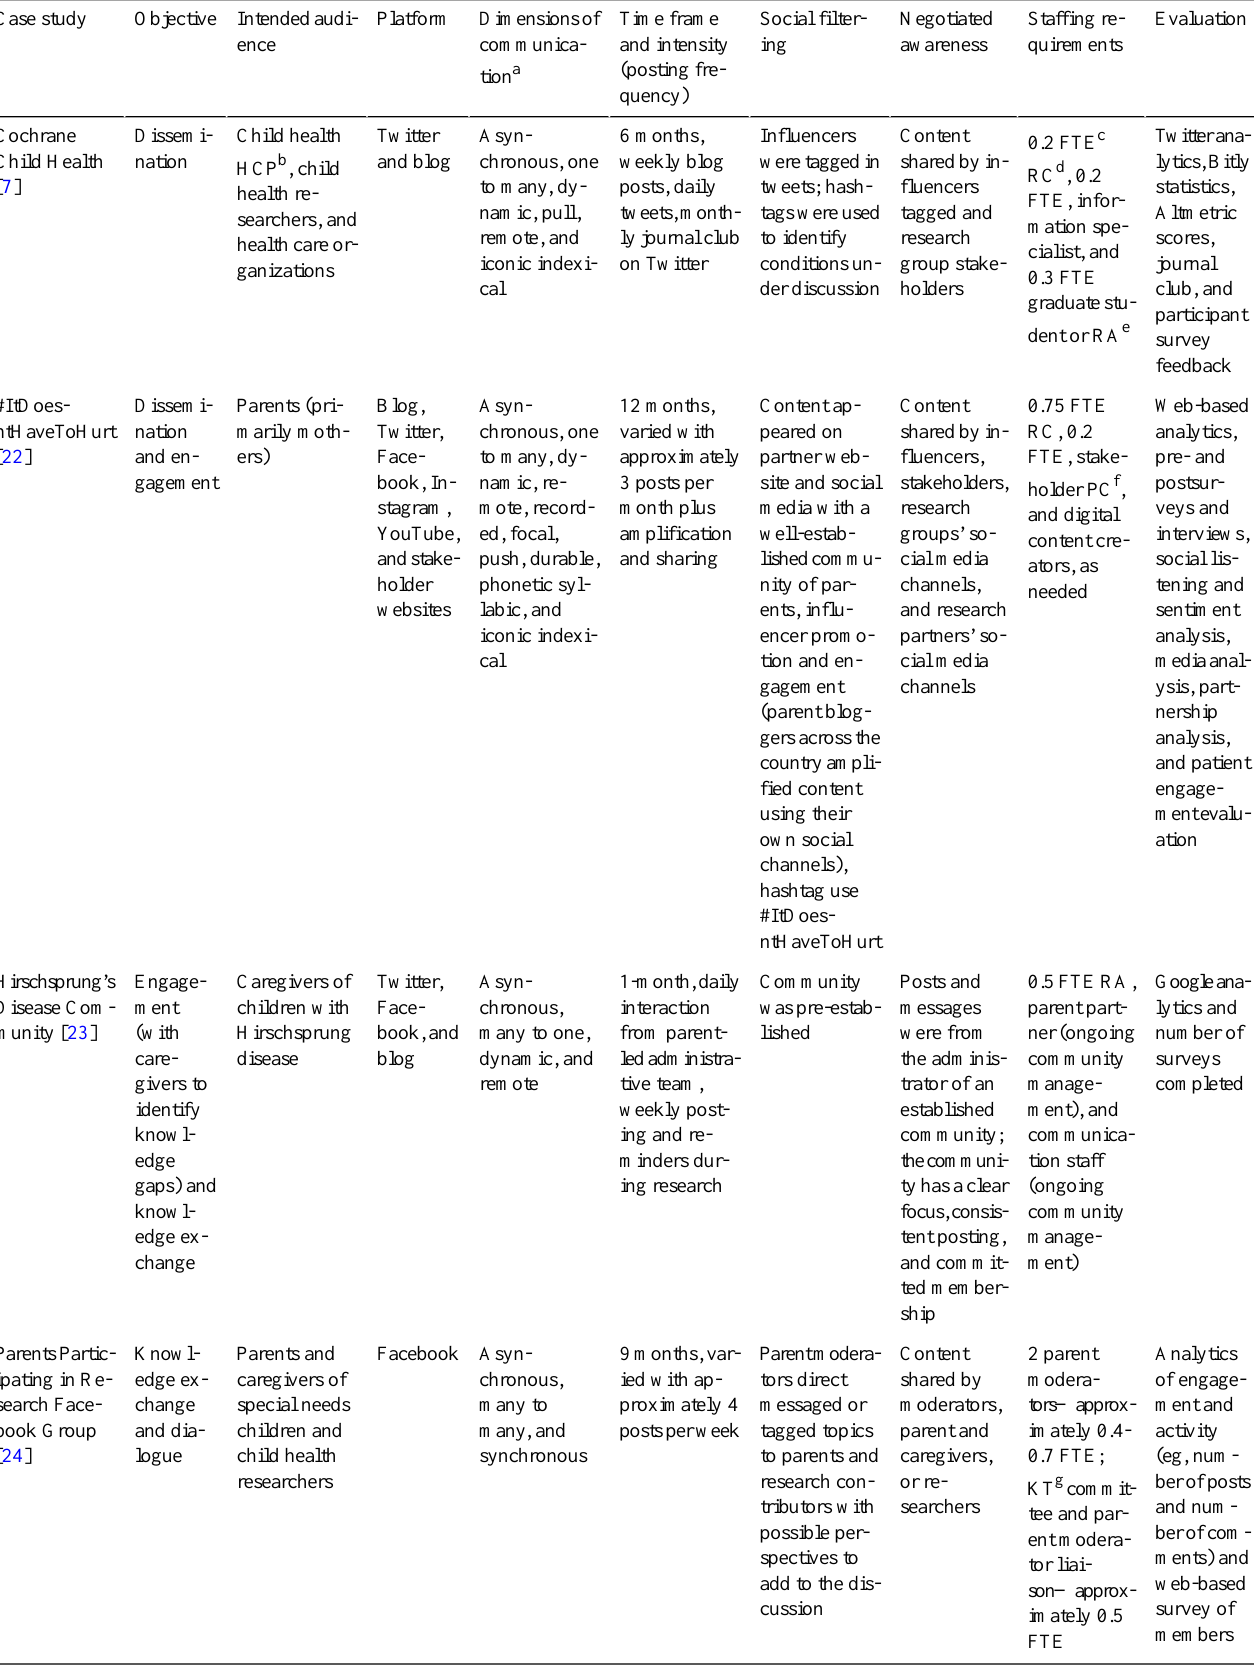
Table 1. Case study